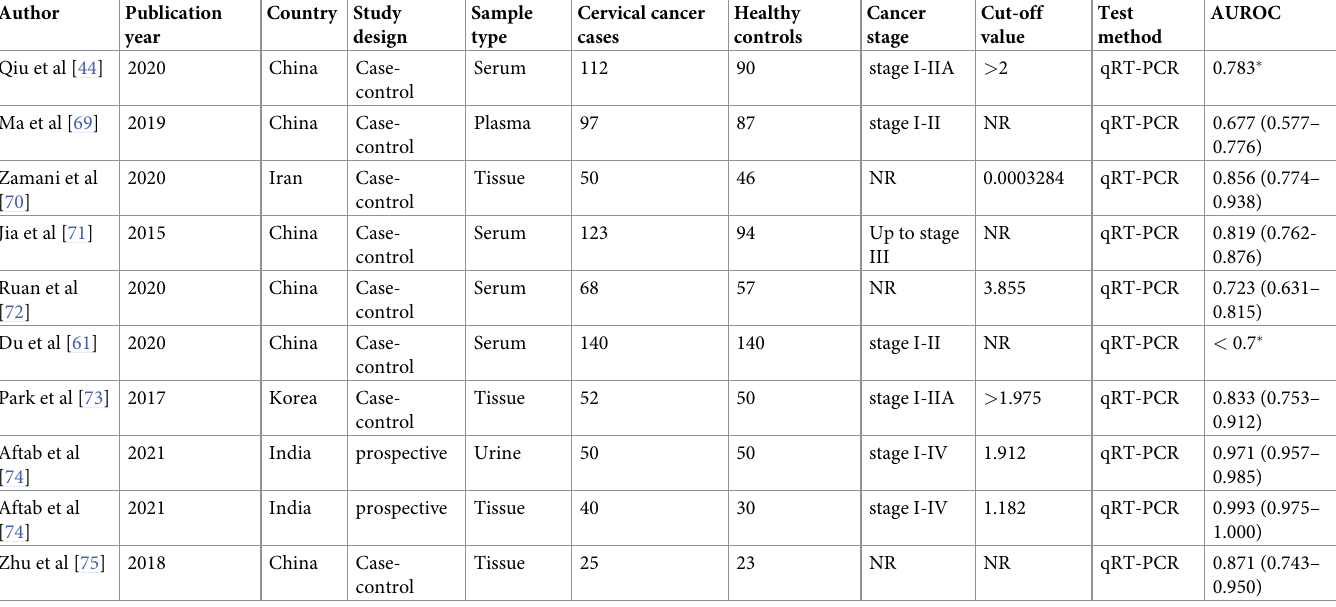
Table 2. The characteristics of included studies (reports) in the systematic review and